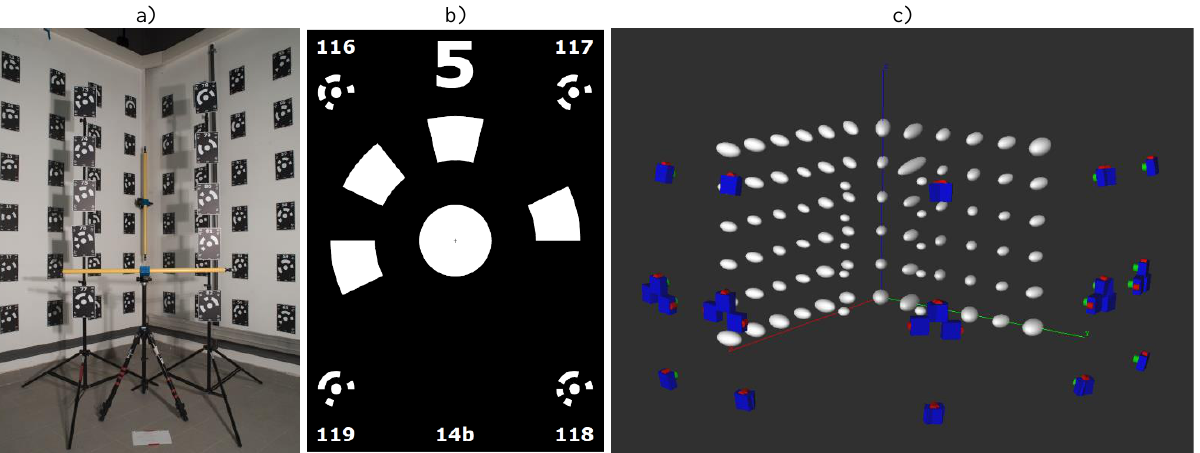
Figure 3. Calibration testfield (a), example of planar target (b) and typical camera network (c) for the geometric calibration of the MAIA multispectral